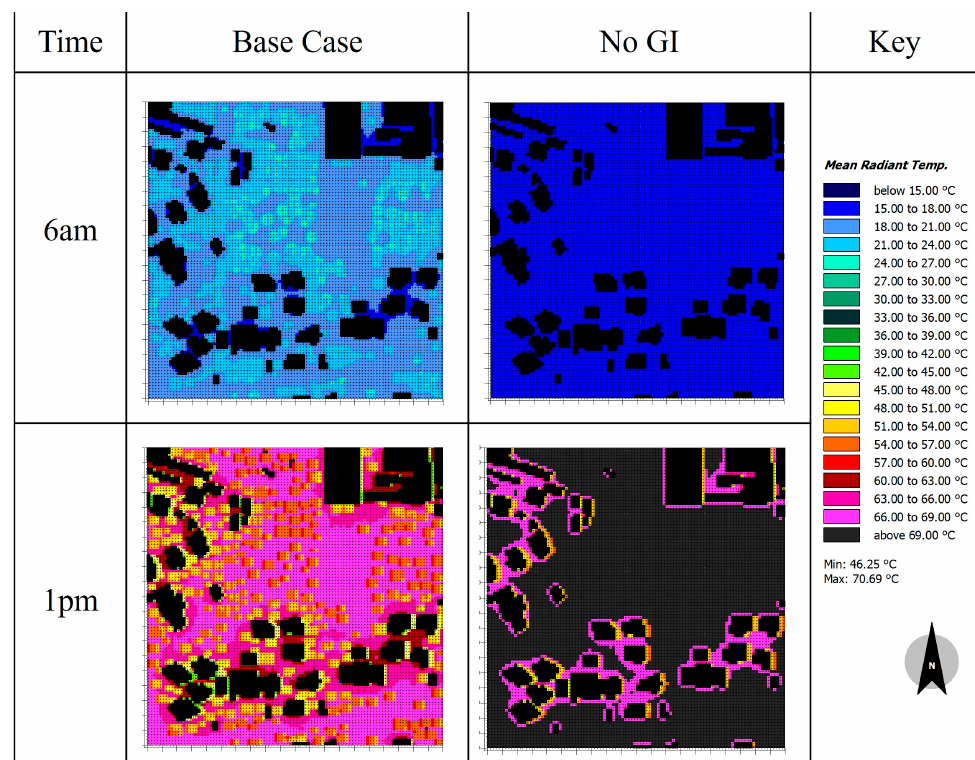
Figure 13. Spatial MRT variations at location 4 for 6 a.m. and 1 p.m. Locations 1 and 2 show MRT variations of 15–18 °C across the domain at 6 a.m. except for the slight increase in MRT of 18–21 °C when GI was present. The density modification